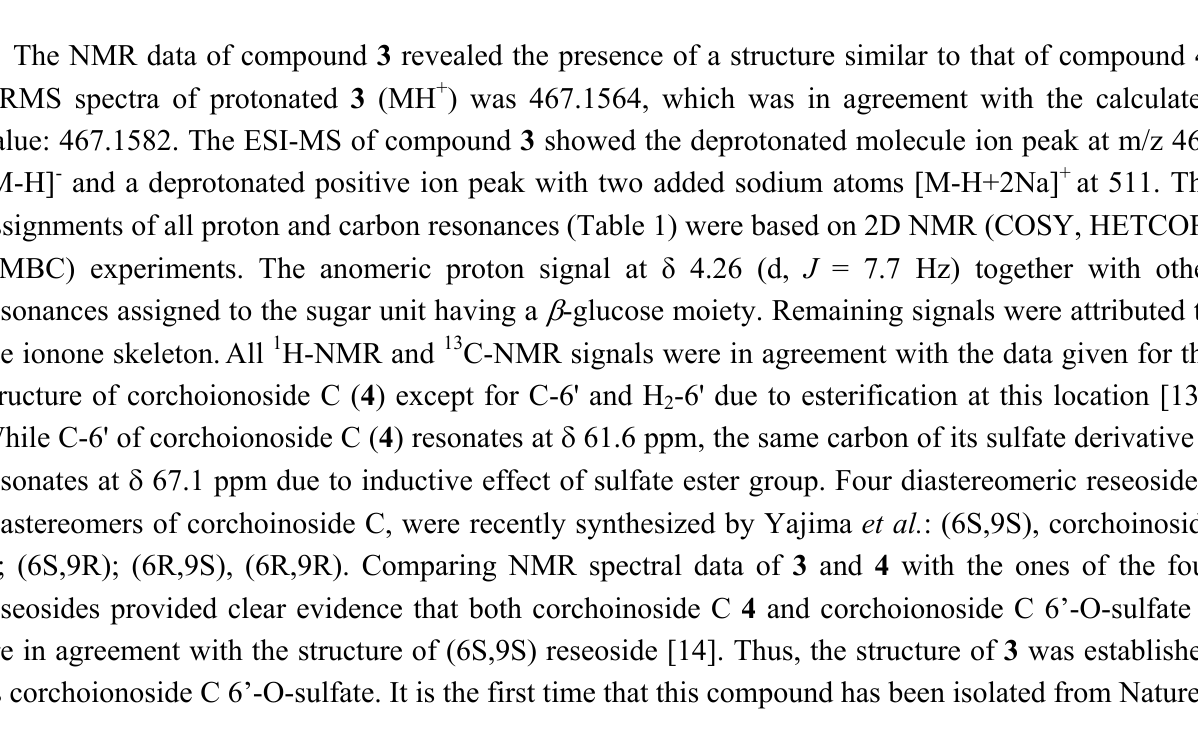
Table 1. NMR Spectroscopic data for compound 3 ( 1 H-NMR: 400 MHz, 13 C-NMR: 100